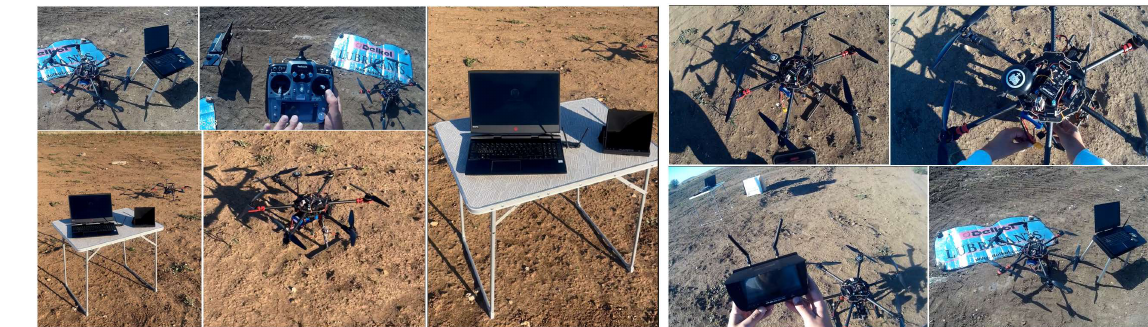
Figure 19. Employed open area test rigs.